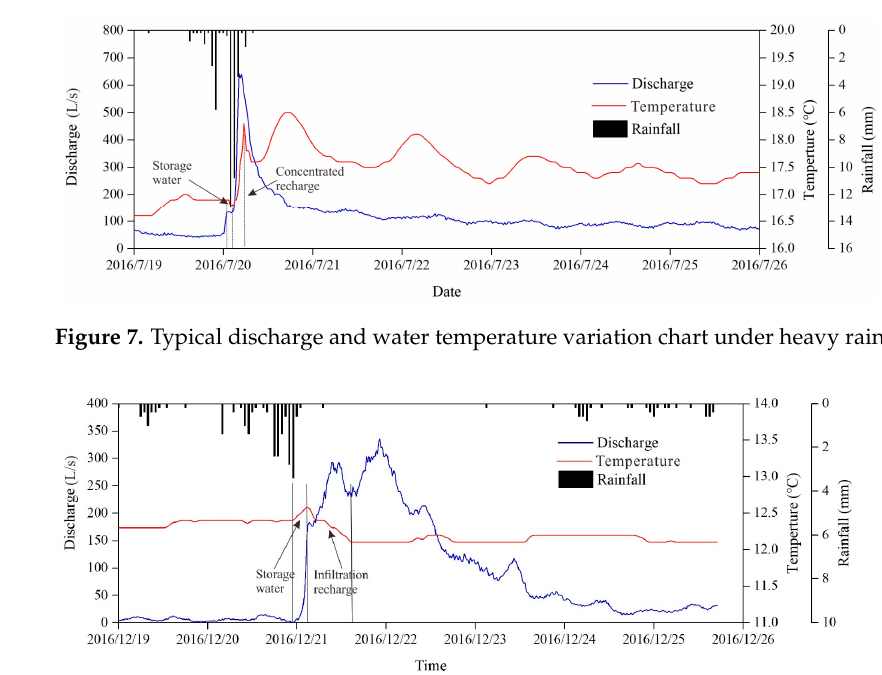
Figure 8. Typical discharge and water temperature variation chart under light rain.